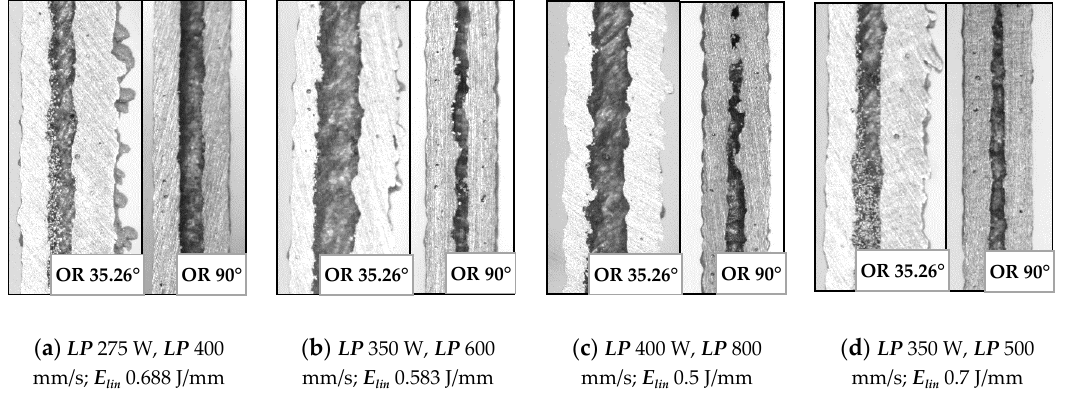
Figure 17. Comparison of inclined and perpendicular strut ( a ) for parameters LP 275 W, LP 400 mm/s; ( b ) LP 350 W, LP 600 mm/s; ( c ) LP 400 W, LP 800 mm/s; ( d ) LP 350 W, LP 500 mm/s.